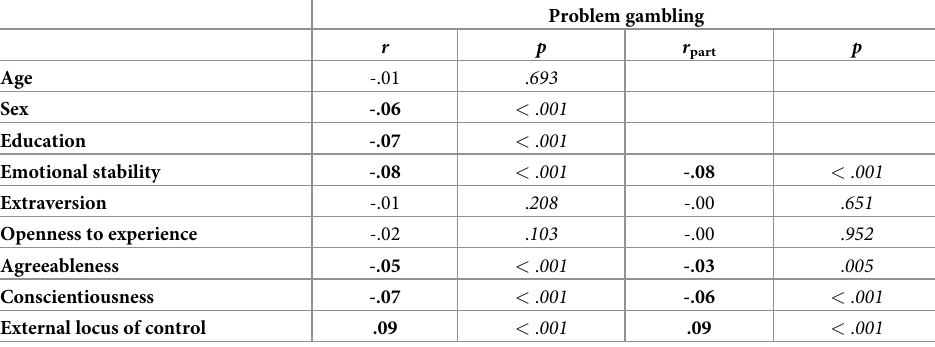
Table 1. Associations of problem gambling with sociodemographic and personality